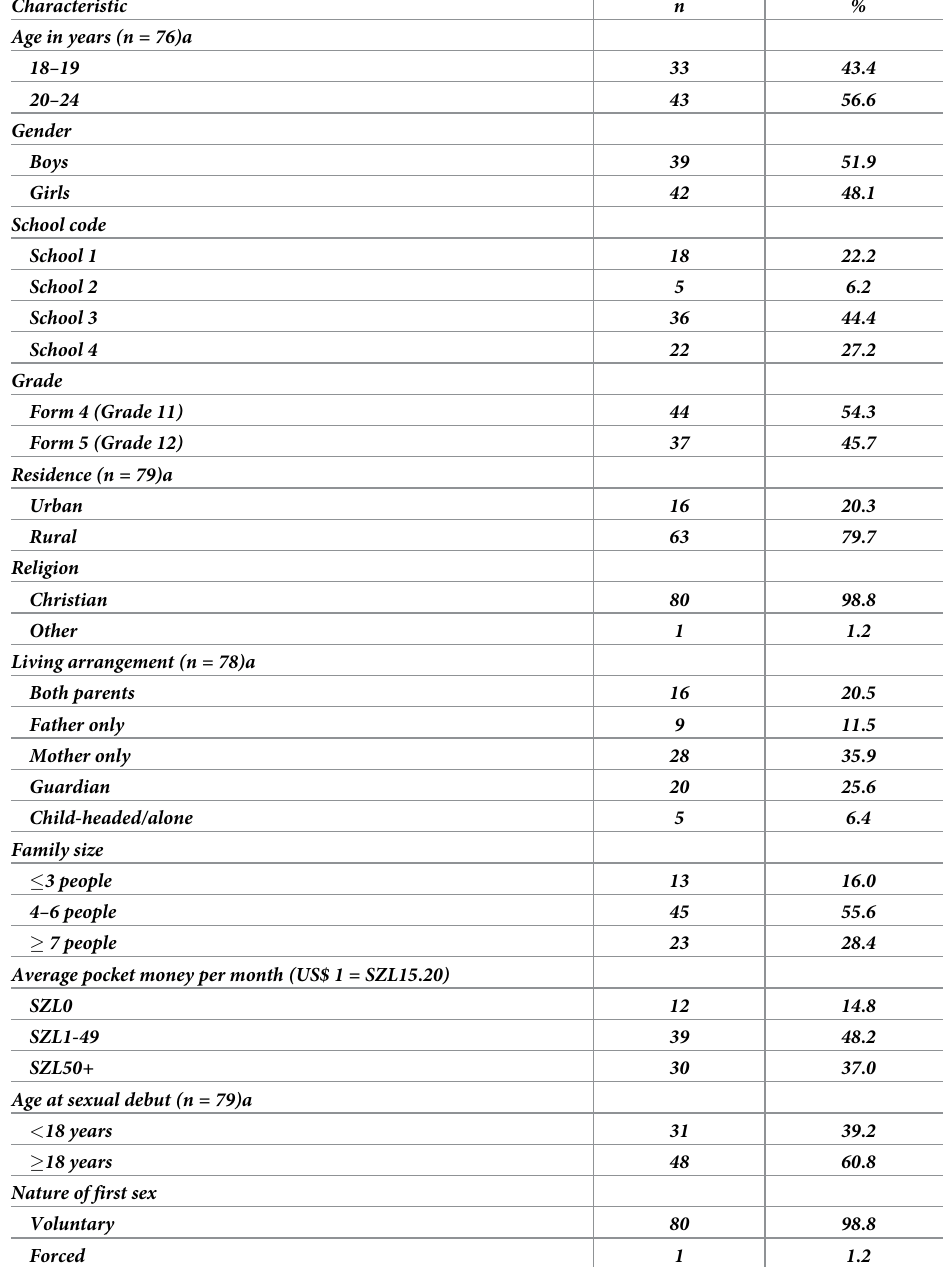
Table 1. Participants’ background characteristics ( N =